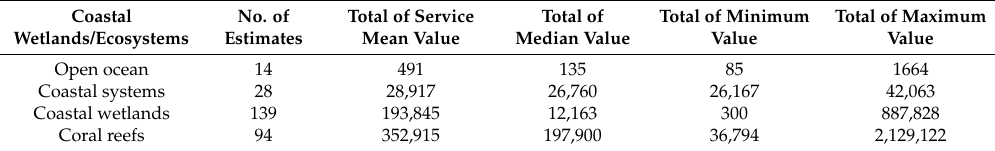
Table 8. Global valuation of coastal ecosystem services (total monetary value per biome). Coastal No. of Wetlands/Ecosystems